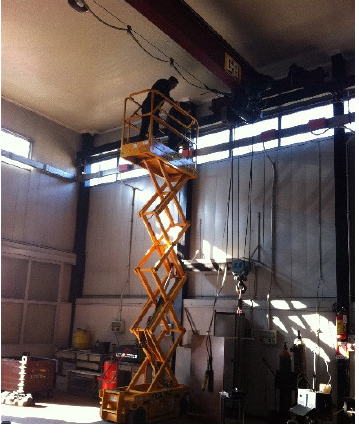
Figure 3. Overhead crane present in building A. The figure shows two operators on lifting platform collecting samples of dust settled on the overhead crane.